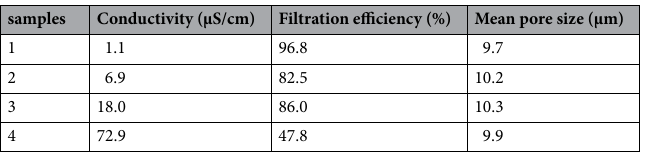
Table 1. Effects of the electrical conductivity of water on the filtration efficiency and mean pore size of MNF.